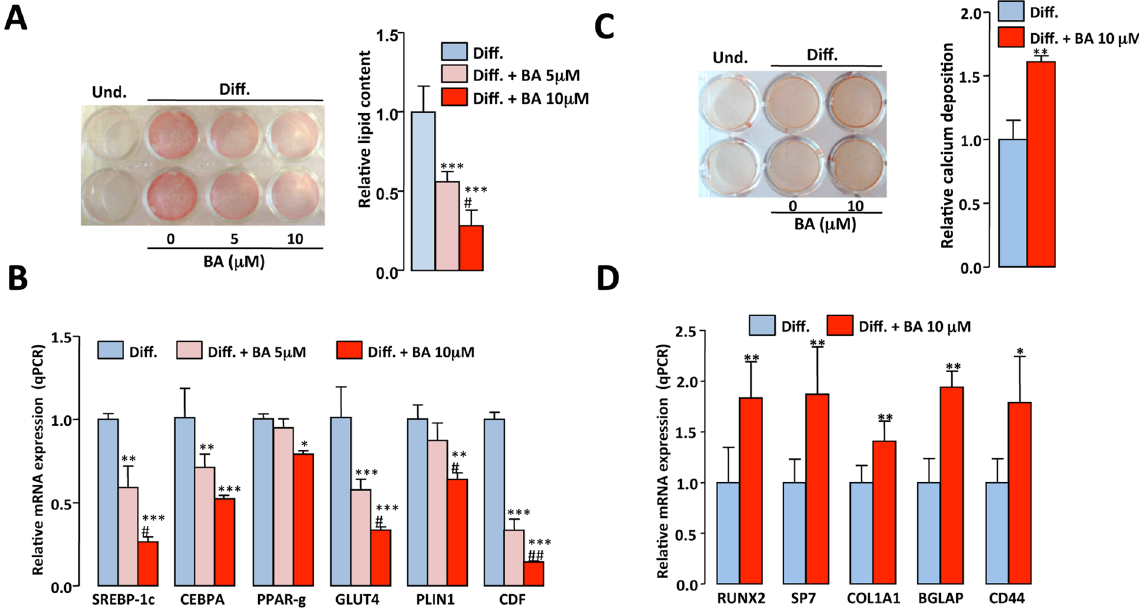
Figure 7. BA decreases differentiation of mouse preadipocytes and increases osteoblast differentiation. 3T3-L1 preadipocytes were induced to differentiate into adipocytes, then were treated with vehicle alone (DMSO) or betulinic acid (BA, 5 or 10 μ M) for 4 days. ( A ) Lipids contained in undifferentiated (Und.) and differentiated (Diff.) cells were stained with Oil Red O (a representative image is shown) then bound dye was solubilized and quantified spectrophotometrically. Values are mean ± SD corrected for the mean value obtained with undifferentiated cells and expressed relative to the differentiated situation. ( B ) Expression levels of adipogenesis- related genes were measured by qPCR. Values are expressed as the means ± SD expressed as fold relative to differentiated (Diff.) situation. * P < 0.05, ** P < 0.01, *** P < 0.001 vs. Diff.; # P < 0.01, ## P < 0.01 vs. Diff. + BA 5 μ M. (one-way ANOVA followed by Bonferroni post hoc test). MC3T3-E1 cells were cultured in osteogenic medium in the absence or presence of betulinic acid (BA, 10 μ M) for 14 days. ( C ) Calcium deposition was identified by Alizarin Red S staining of undifferentiated (Und.) and differentiated (Diff.) cells (a representative image is shown), and then bound dye was extracted and quantified spectrophotometrically. Values are expressed as in Fig. 7A. ( D ) Expression levels of osteogenesis-related genes were measured by qPCR. Values are expressed as in Fig. 7B. * P < 0.05, ** P < 0.01, vs. Diff.; (Unpaired